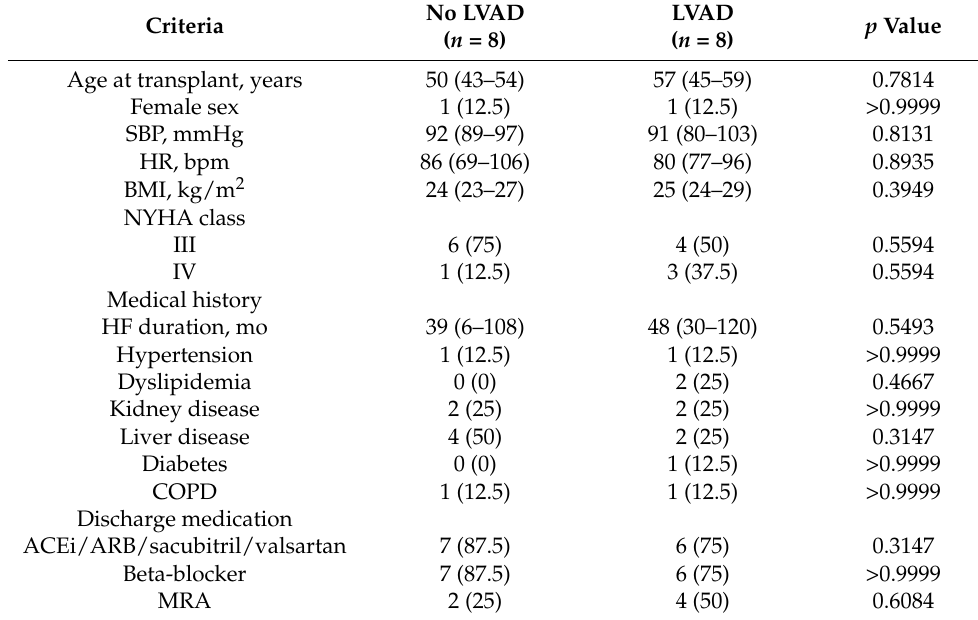
Table 1. Clinical characteristics of DCM patients with and without LVAD